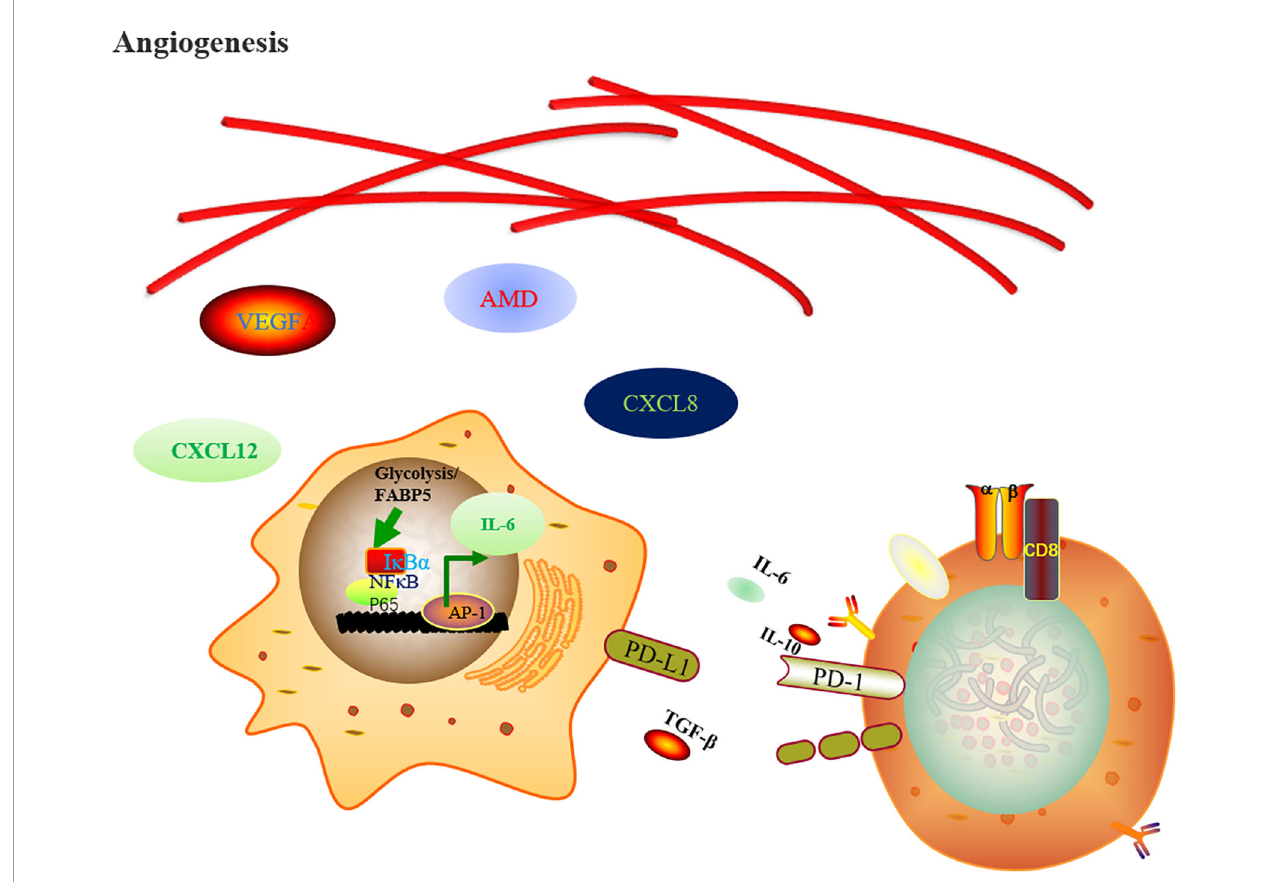
FIGURE 1 | Regulation of metabolic rewiring upon macrophage cells activation. The TAM-derived hypoxia and glucose metabolism products favor neoangiogenesis through endothelial growth factor A (VEGFA), adrenomedullin (AMD), C-X-C motif chemokine ligand 8 (CXCL8), and CXCL12. In the meantime, the FABP5 and the metabolite of glycolysis favor the tumor progression by expression of IL-6 and PD-L1 through NF- k B pathway signaling inhibiting CD8+ T cells anti-tumor